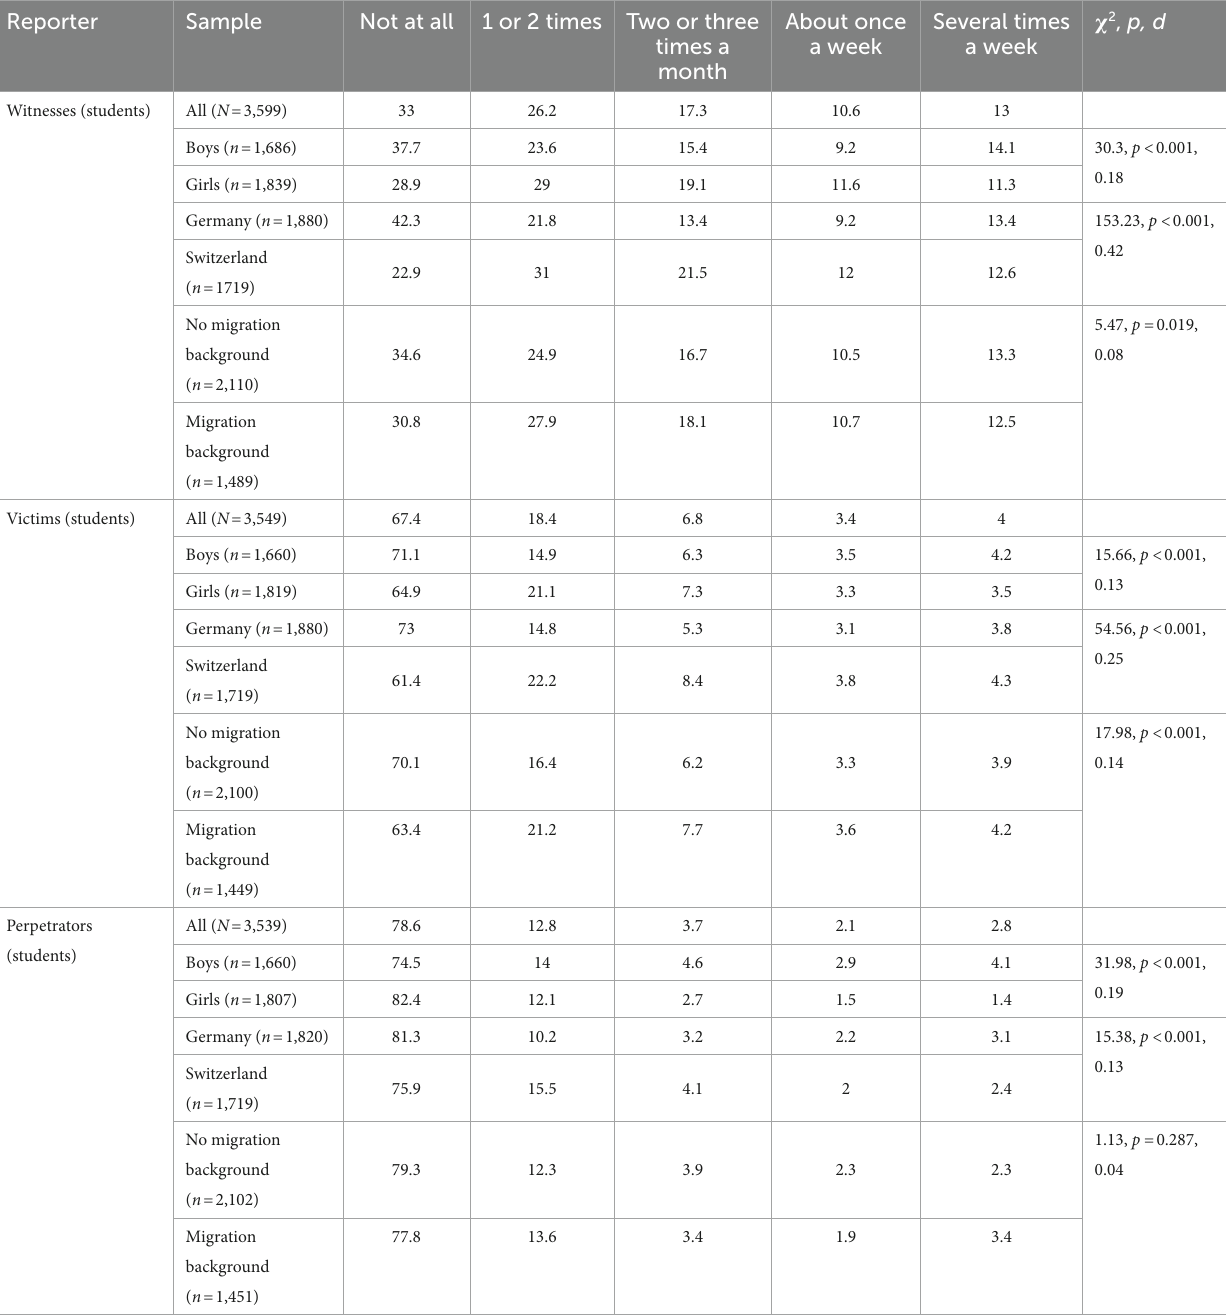
TABLE 1 Frequency of witnessed, experienced and perpetrated offline hate speech, by country, gender and migration status of reporters. Reporter Sample Not at all 1 or 2 times Two or three